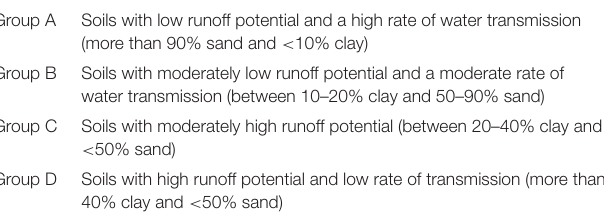
TABLE 1 | Hydrological soil groups according to USDA classification. Group